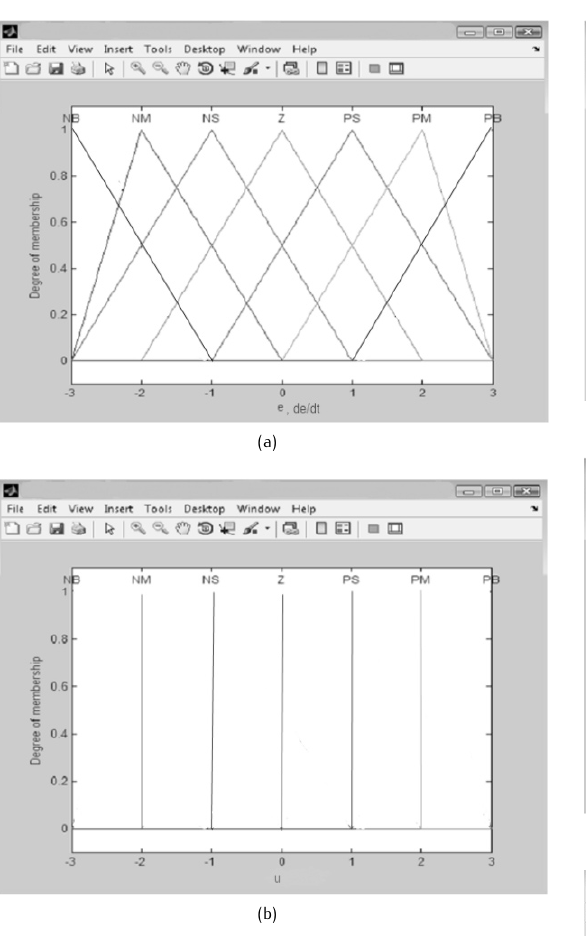
Figure 2. Membership functions of the PD controller. a) inputs ( e ), ( de/dt ); b) output variables ( u ).